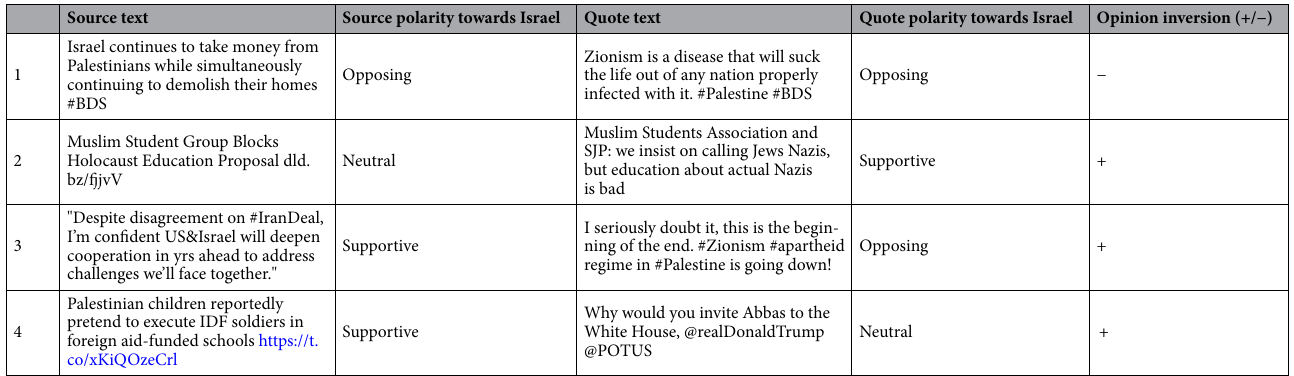
Table 1. Examples of Sources and Quote-retweets, and their Polarity about the example domain. A Tweet will undergo Opinion Inversion when the sentiment polarity toward Israel of the Quote does not match that of its Source.